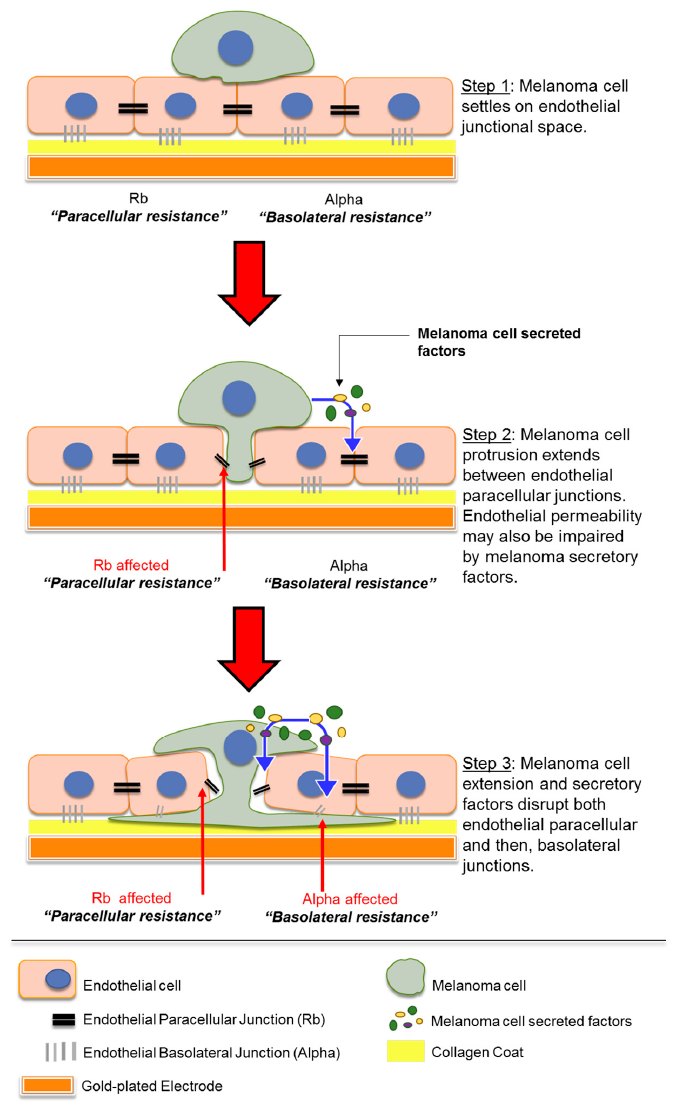
Figure 9. Schematic showing possible sequence of events which occur when melanoma cells encounter endothelial monolayer. Paracellular resistance (Rb) and basolateral resistance (Alpha) together form the overall barrier resistance of the endothelial monolayer. Diagram not to scale.